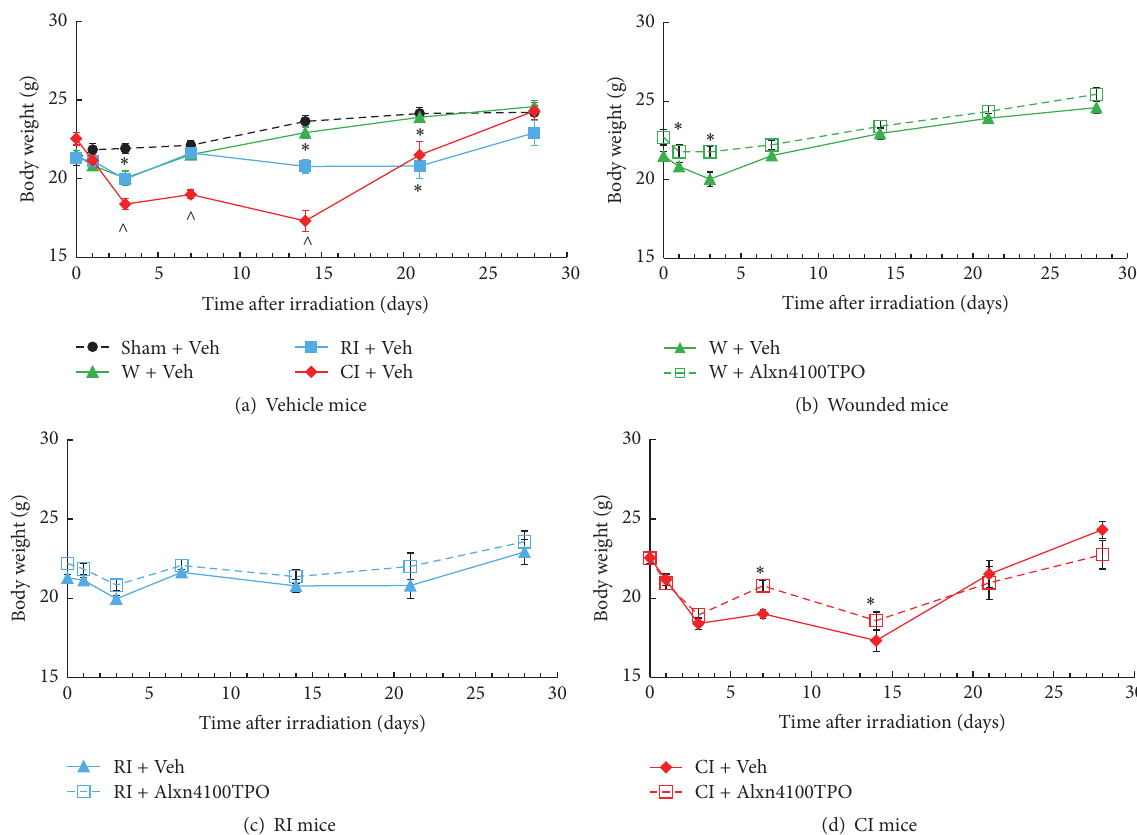
Figure 7: RI and CI decreased body weight and Alxn4100TPO significantly improved body-weight loss after CI. Body weights of animals were measured on days 1, 3, 7, 14, 21, and 28. 𝑁 = 19–22 per group. Data are presented as mean ± sem. For panel (a): ∗ 𝑝 < 0.05 versus sham, W, and CI; ∧ 𝑝 < 0.05 versus sham, W, and RI. For panel (d): ∗ 𝑝 < 0.05 versus CI + Vehicle. Veh: vehicle; W: wound; RI: 9.5 Gy; CI: 9.5 Gy and skin